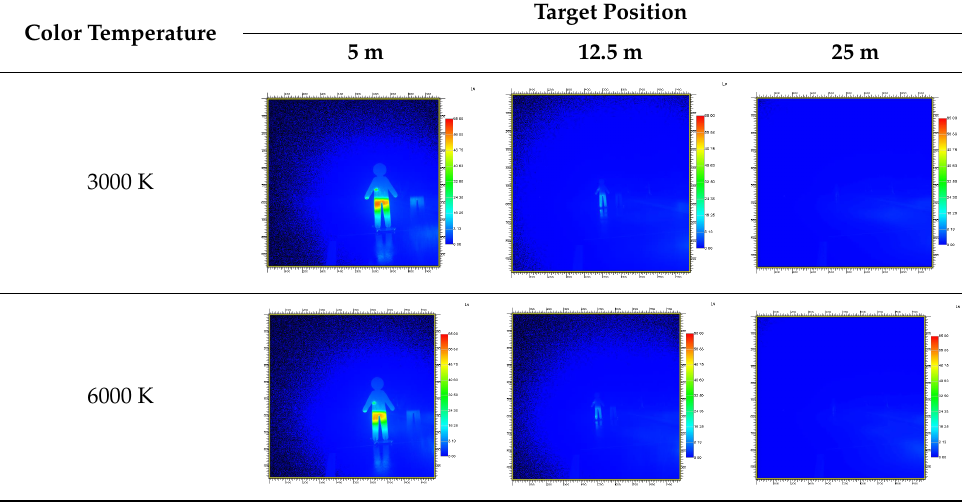
Table 12. Comparison of luminance by target distance and color temperature (rain 50 mm/h).